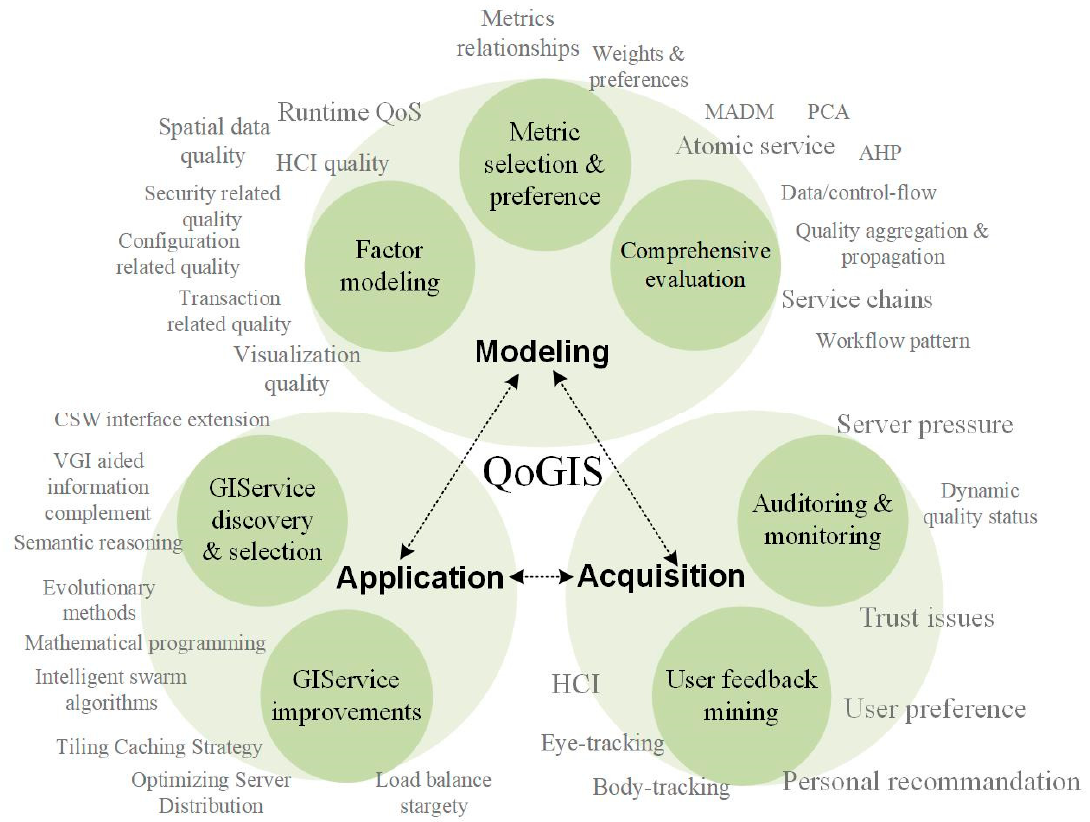
Figure 2. Conceptual framework for QoGIS research.